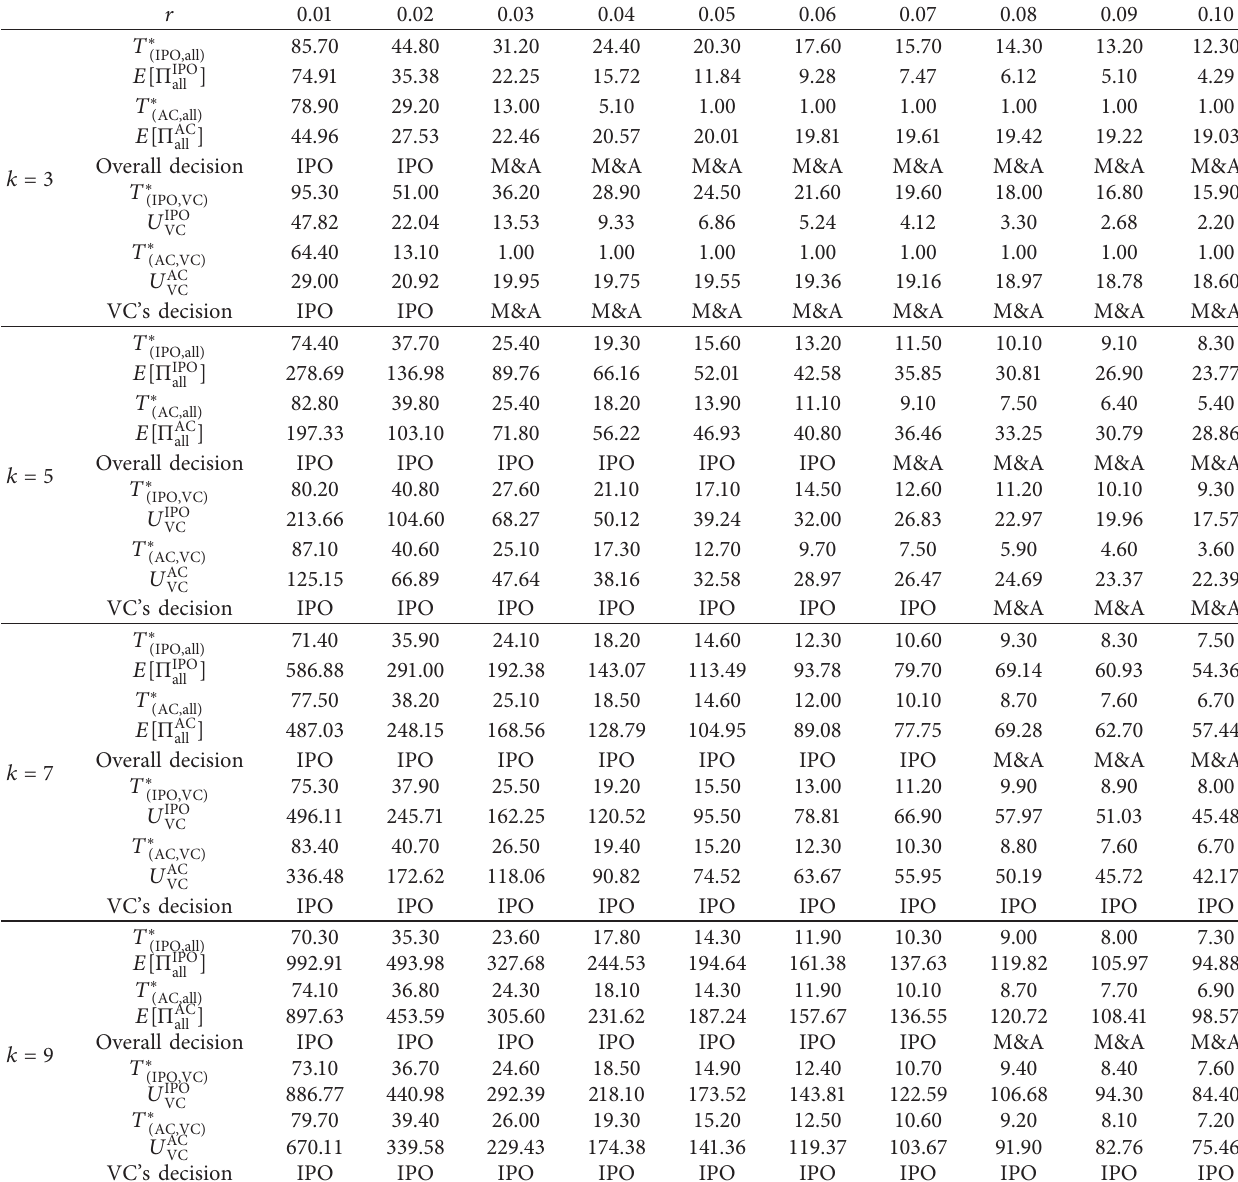
Table 2: Numerical simulation for exit